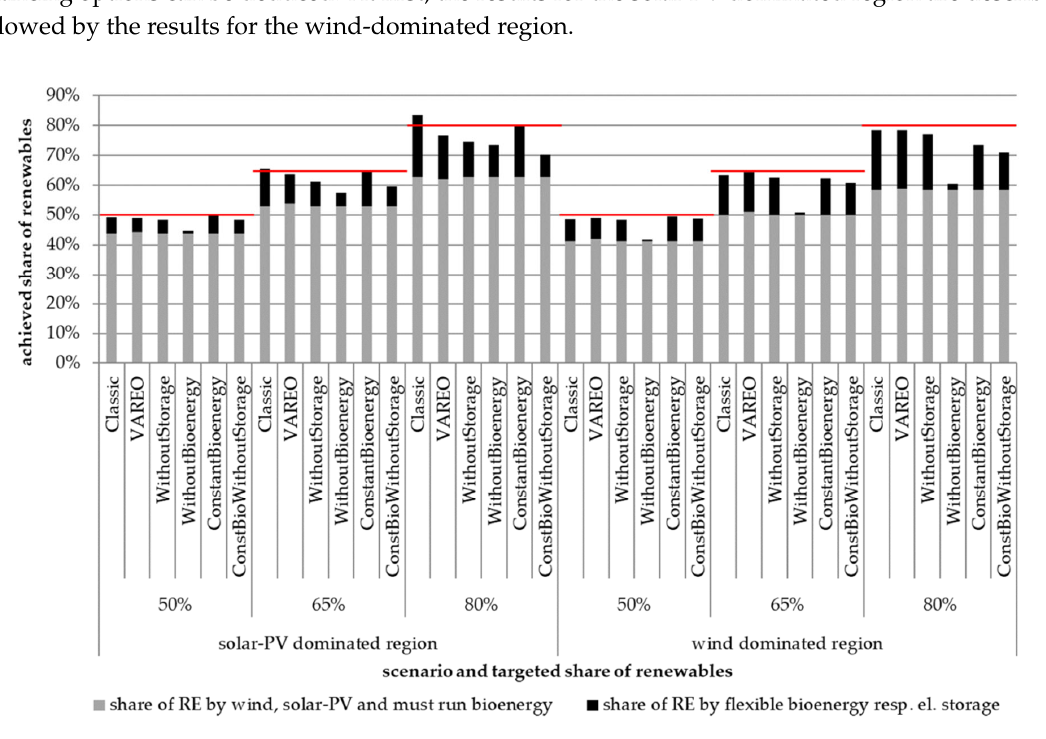
Figure 7. Overview of achieved share of renewables in sensitivity analysis.